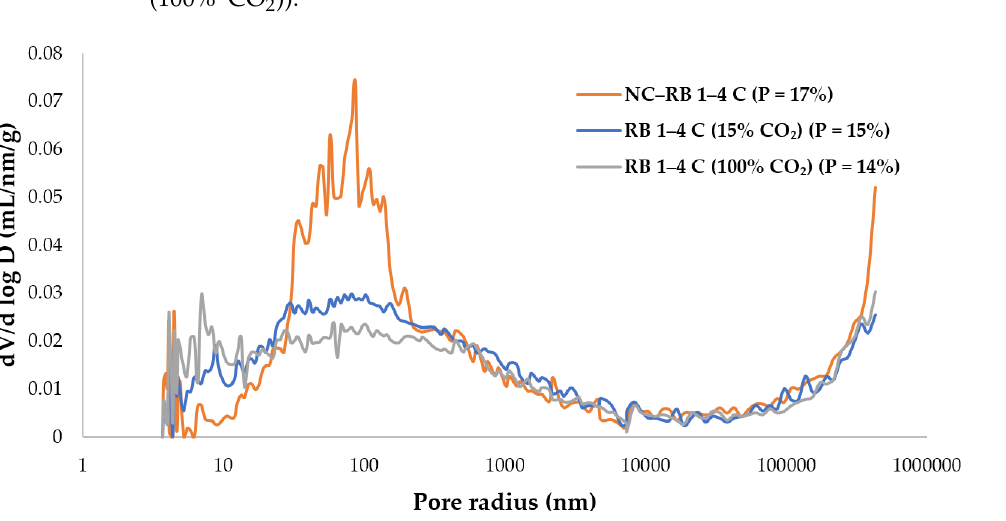
Figure 18. Pore size